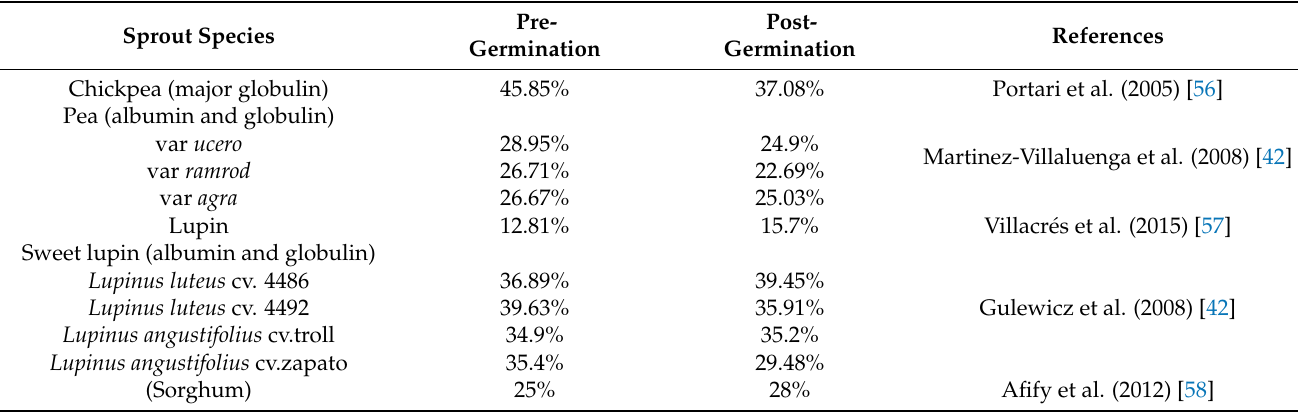
Table 2. Changes in soluble protein fractions (percentage of total protein) after